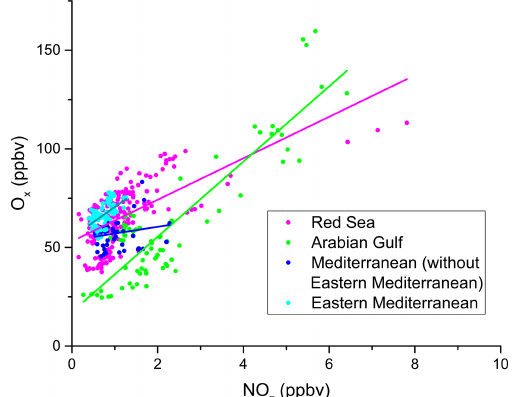
Figure 14. Correlation between O x ( = O 3 + NO 2 ) and NO z dur- ing AQABA, with the regions indicated via the colour code. Only daytime measurements were used in this analysis. The OPEs for AQABA and for the individual regions shown in Table 4 were de- rived from linear fits of these data points. A clear regional variabil- ity can be observed for O x and NO z mixing ratios. Elevated O x and NO z levels were measured in the Arabian Gulf and the Red Sea.